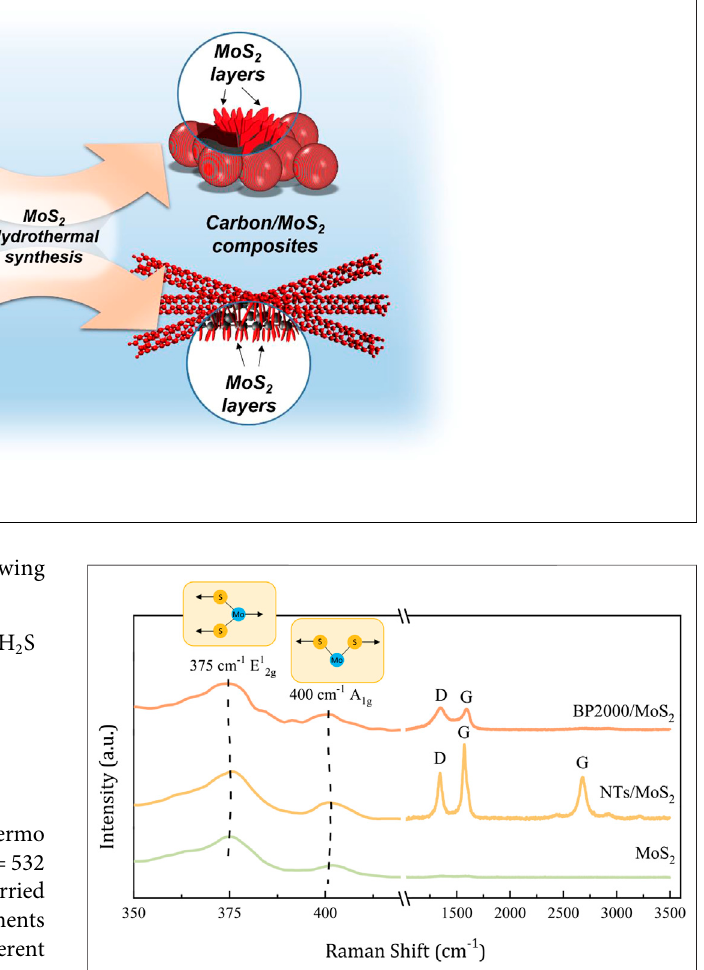
FIGURE 2 | Raman spectra of BP2000/MoS 2 , NTs/MoS 2 , and MoS 2